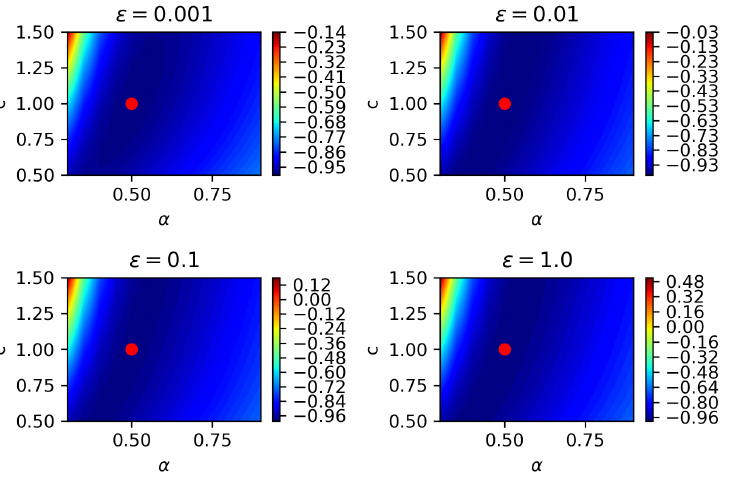
Figure 9. Two-parameter estimation for a full observation: Contour plots of normalized negative log-likelihood for pairs of ( α , c ) ∈ [ 0.3,0.9 ] × [ 0.5,1.5 ] . The effect of noise magnitude on the estimated parameters is demonstrated. The true values for α and c are α ∗ = 0.5 and c ∗ = 1.0. The plots for different noise magnitudes are compared. For all plots, the controlling parameters for partial observation are fixed to r x = r t = 1 (namely, a full observation). The red disk represents the optimal parameter pair that minimizes the negative log-likelihood.